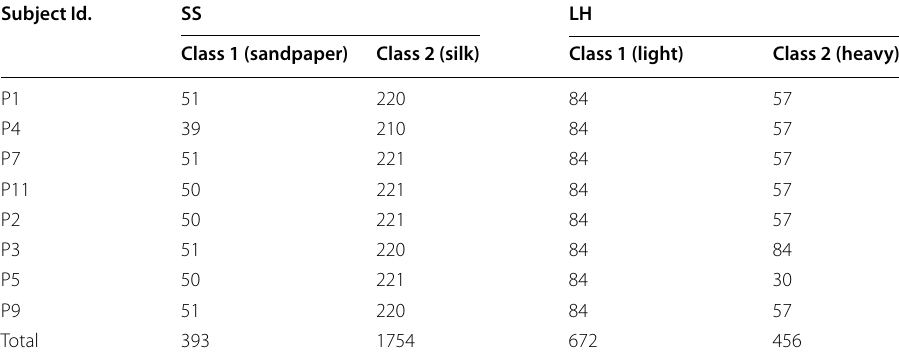
Table 1 Number of EEG and EMG segments available in each class of each classification problem Subject